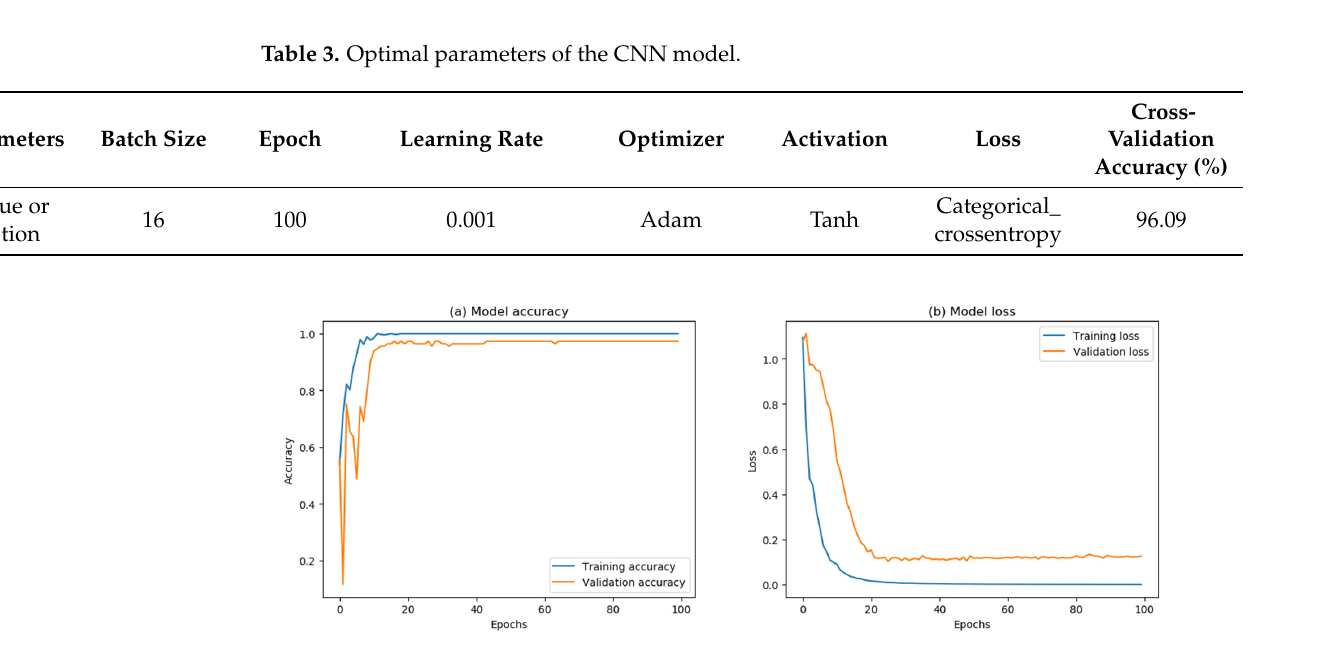
Figure 5. ( a ) Accuracy curves of training set and validation set. ( b ) Loss curves of training set and validation set.